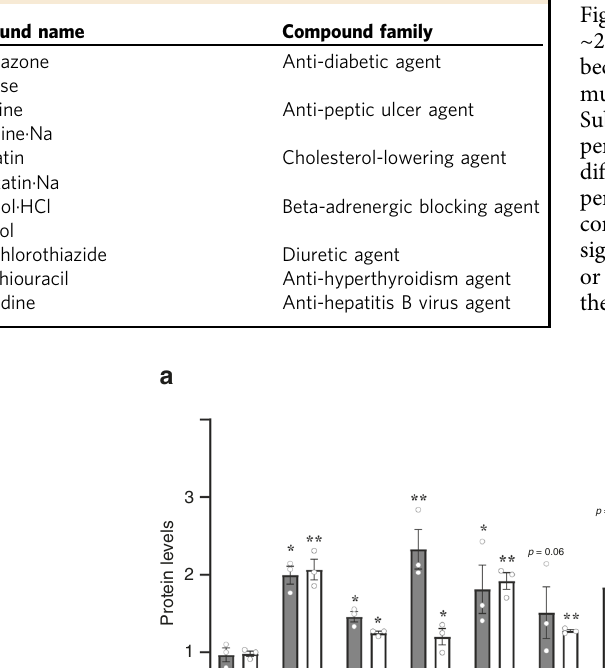
Table 1 eEF1A2 and utrophin A activating FDA-approved drugs identi fi ed using an ELISA-based high-throughput screen.